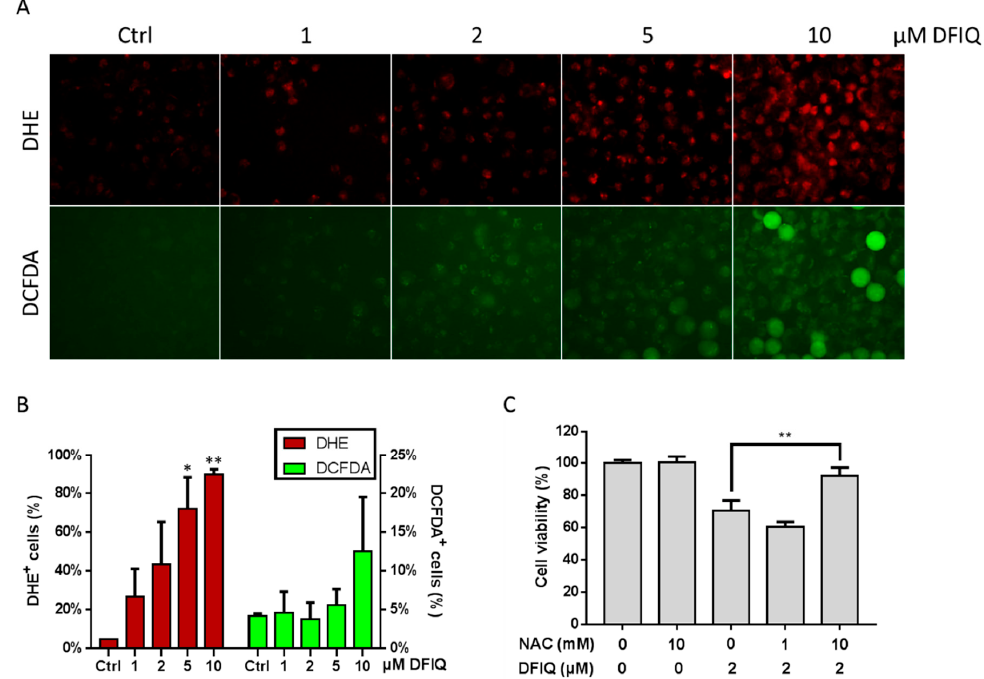
Figure 3. Reactive oxygen species (ROS) formation is associated with DFIQ-induced apoptosis. ( A ) H1299 cells treated with different concentrations of DFIQ for 6 h were stained with dihydroethidium (DHE) or 2’,7’-dichlorofluorescein diacetate (DCFDA) to detect O 2 − or H 2 O 2 formation, respectively. ( B ) Quantification of O 2 − or H 2 O 2 formation in ( A ). ( C ) The viability of cells pretreated with the ROS inhibitor N-acetylcysteine (NAC) prior to treatment with DFIQ was monitored. ** p < 0.01, * p < 0.05 compared with the control group.